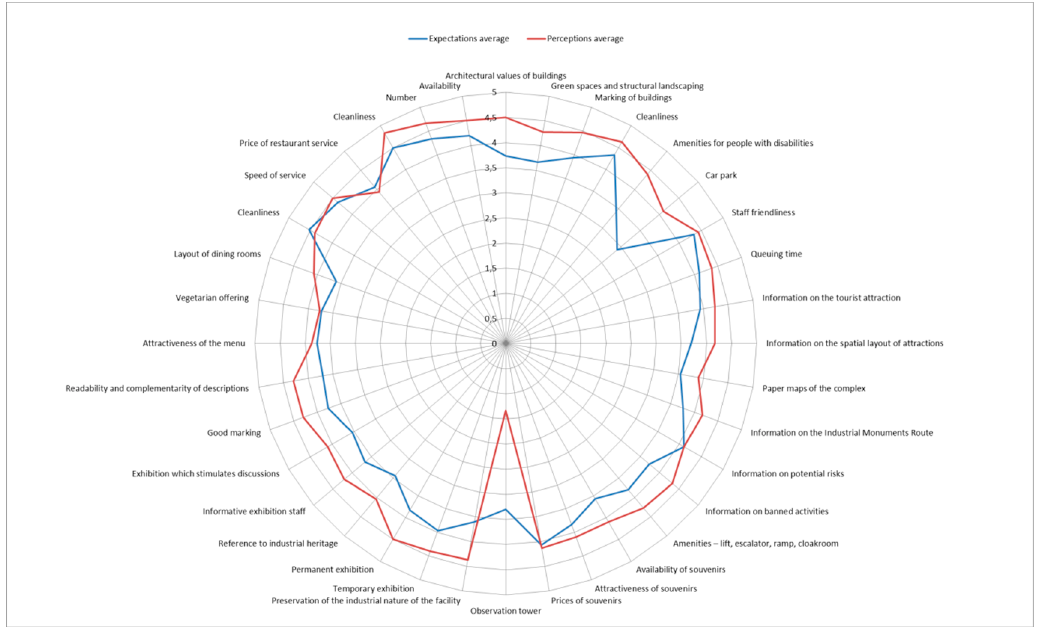
Figure 6. The charts of the dependence of expectations and perception of individual items in the questionnaire (source: own study).